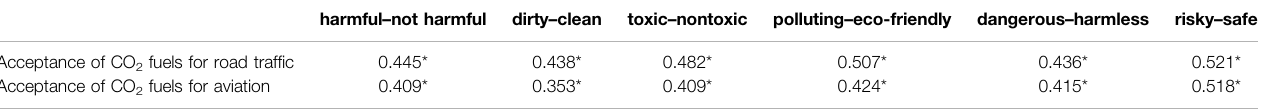
TABLE 2 | Bivariate correlations of acceptance of CO 2 -based fuels and risk perception ratings (scale: e.g., 1 (cid:1) toxic, 10 (cid:1) nontoxic). harmful – not harmful dirty – clean toxic – nontoxic polluting – eco-friendly risky –